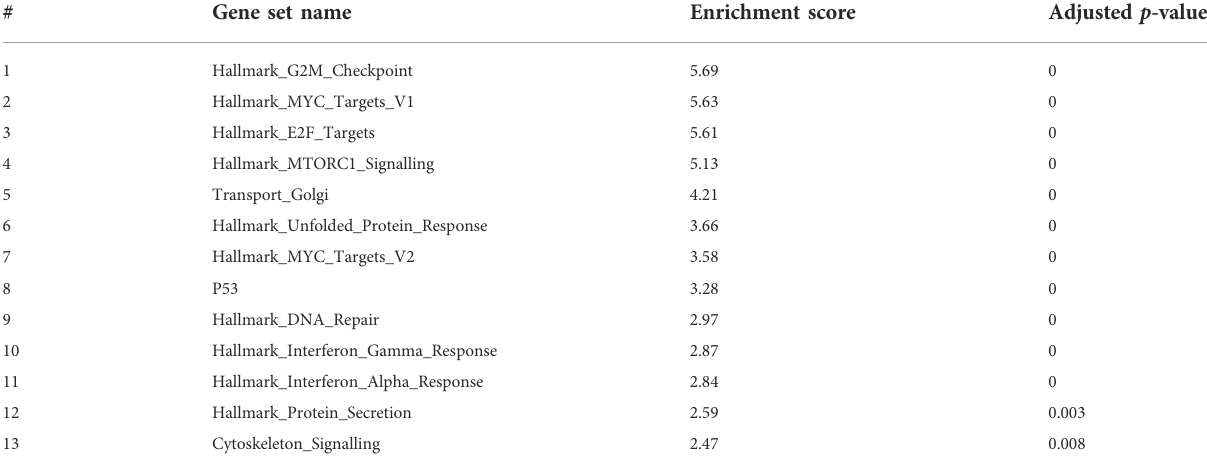
TABLE 8 Gene Set Enrichment Analysis (GSEA) of gne KO versus gne WT zebra fi sh at 7